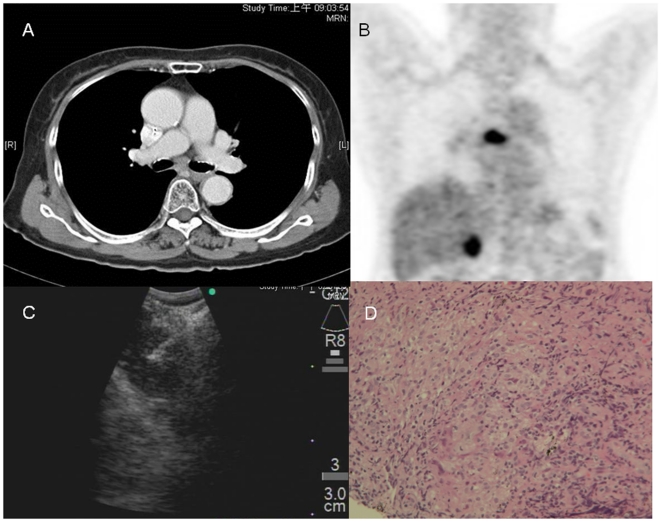
A representative case of a PET scan with negative impact.(A) The contrast-enhanced CT scan shows small lymph nodes measuring 0.8×0.6 cm in the subcarinal area. (B) The PET scan shows increased FDG uptake at the corresponding site (gall bladder uptake due to cholecystitis). (C) The subcarinal lymph node was later targeted by EBUS-TBNA(D) A tissue core, which revealed granulomatous inflammation consisting of epithelioid histiocytes (upper right; H&E stain, 200×) was obtained.